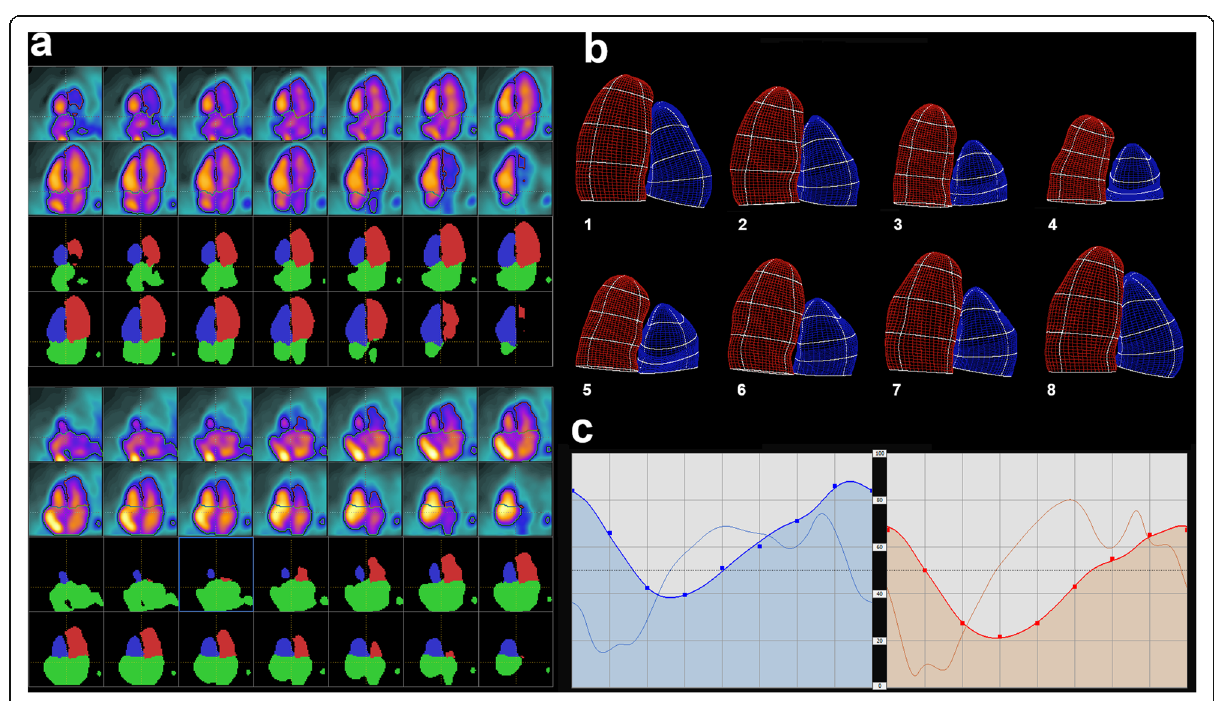
Fig. 4 Example of a rest first-pass 15 O-water PET study post-processed using TomPool. a Horizontal long-axis slices and corresponding segmentation (red: LV, blue: RV, green: extra-ventricular activity) at end-diastole (top) and end-systole (bottom). b Parametric surfaces built from the segmentation masks (red: LV, blue: RV) at each gating time sample. c Time-volume curves for LV (red) and RV (blue) computed using the deformable curve